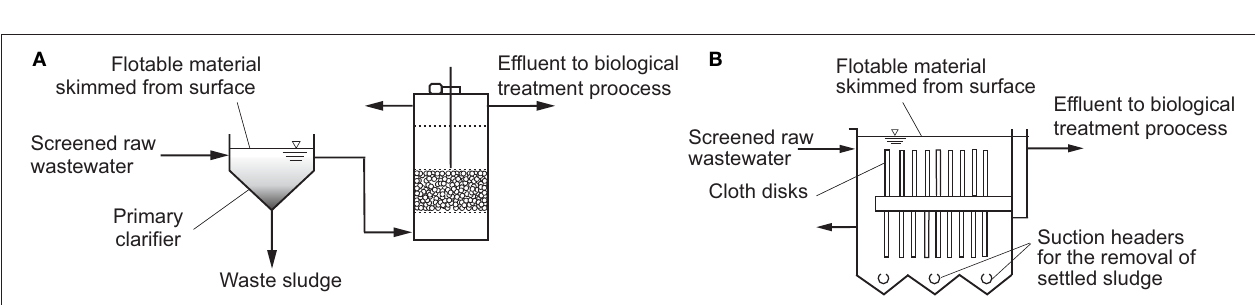
FIGURE 2 | Typical hourly variations observed in flow, BOD concentrations, and BOD mass-loadings in influent after screening and grit removal (A) unequalized, measured values and (B) flow equalized values based on the data in (A) . The required flow equalization volume is 4.1ML (1.1 Mgal) (adapted from Tchobanoglous et al., 2014).